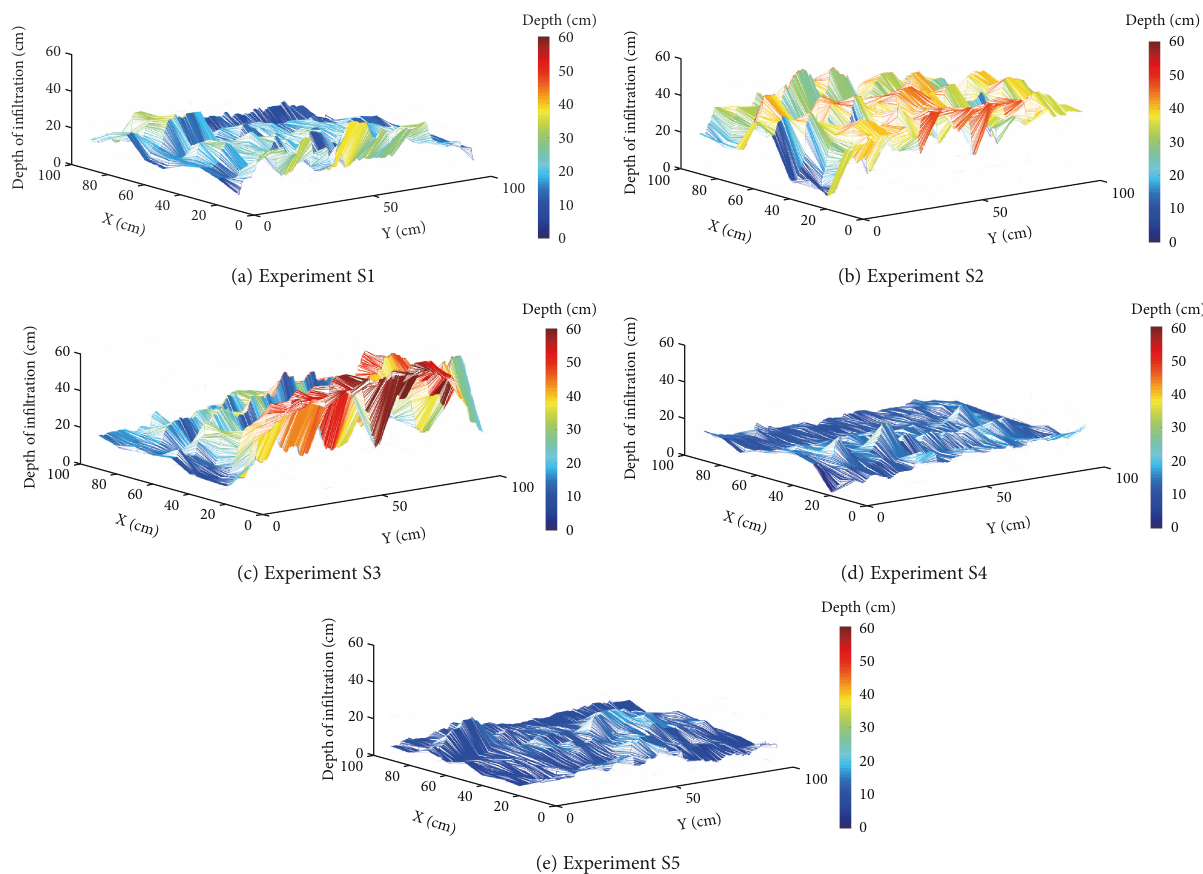
Figure 5: The distribution of the in fi ltration